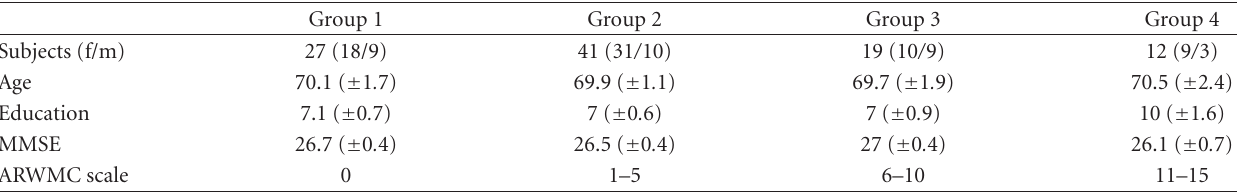
Table 1: Mean values ± standard error of demographic characteristics, neuropsychological and ARWMC scores of the MCI subgroups. F/M: female/male. Age and education are expressed in years. Group 1: no vascular damage; group 2: mild vascular damage; group 3: moderate vascular damage; group 4: severe vascular damage. Group 1 Group